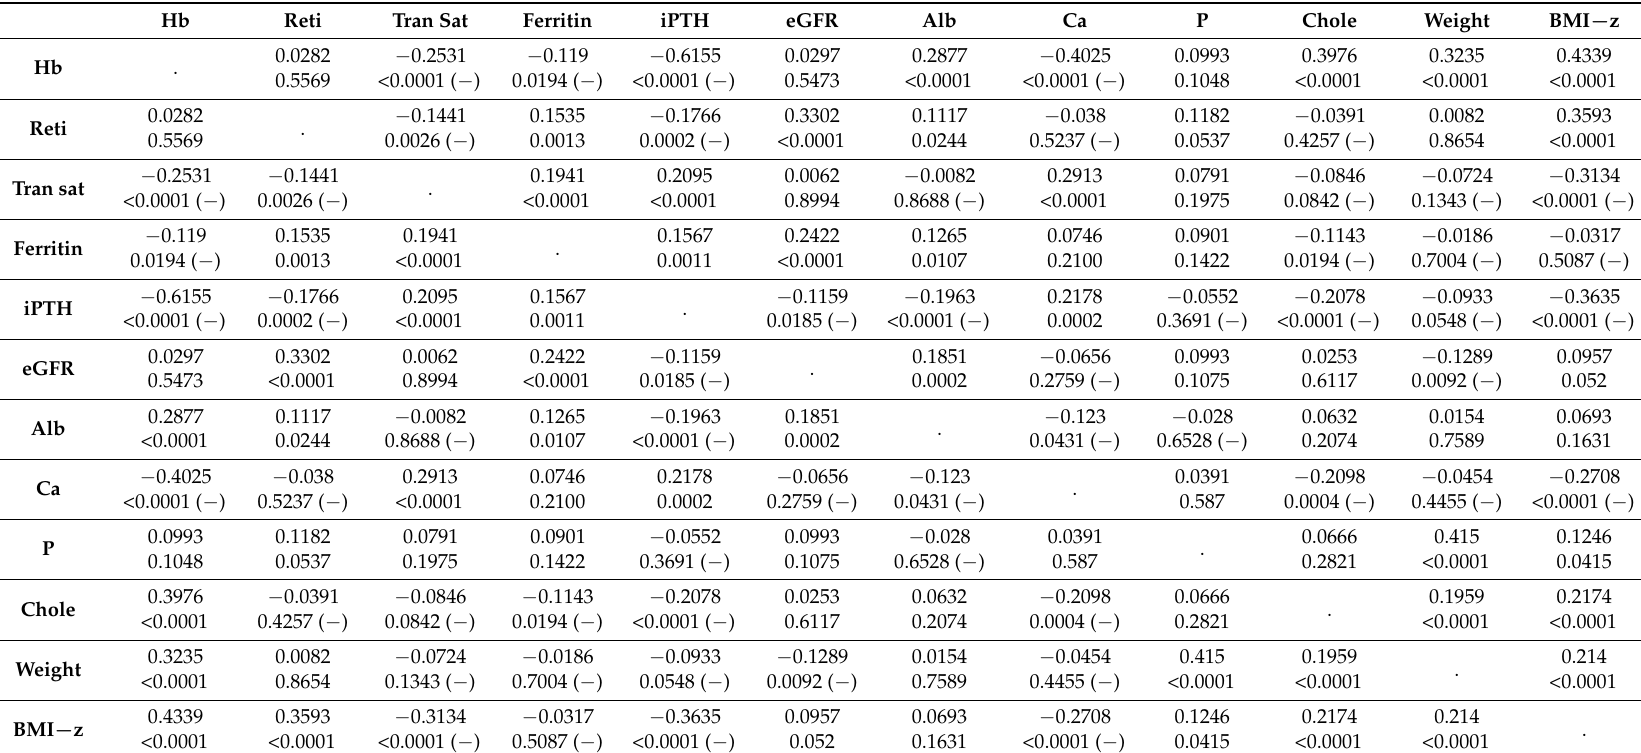
Table 7. Correlations among key characteristics of anemic children in the CKD